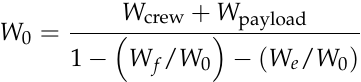
Figure 5. Fixed-wing UAV missions.